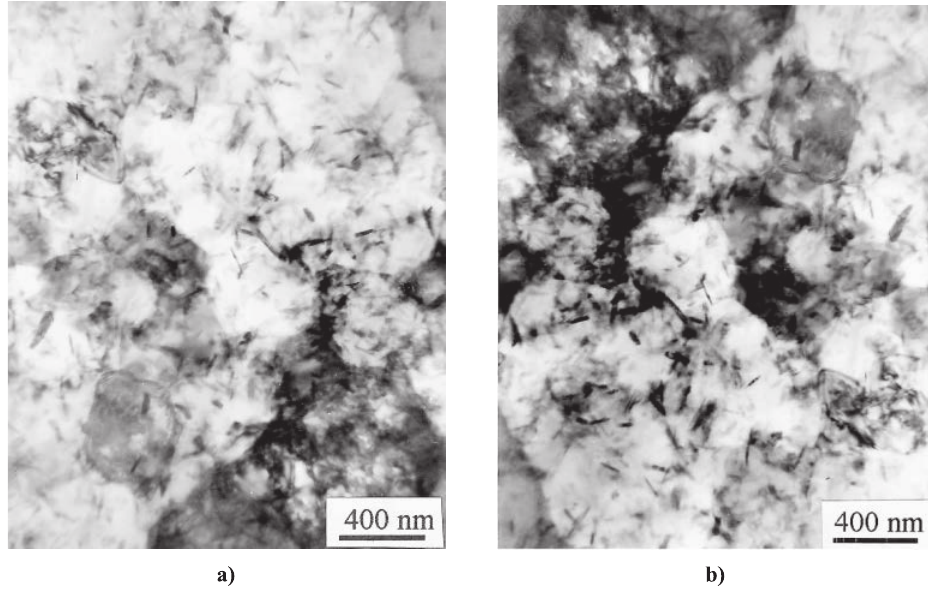
Fig. 13: Submicrostructure (foil) of Al-12Al 4 C 3 material, (a) the transverse direction, (b) longitudinal direction